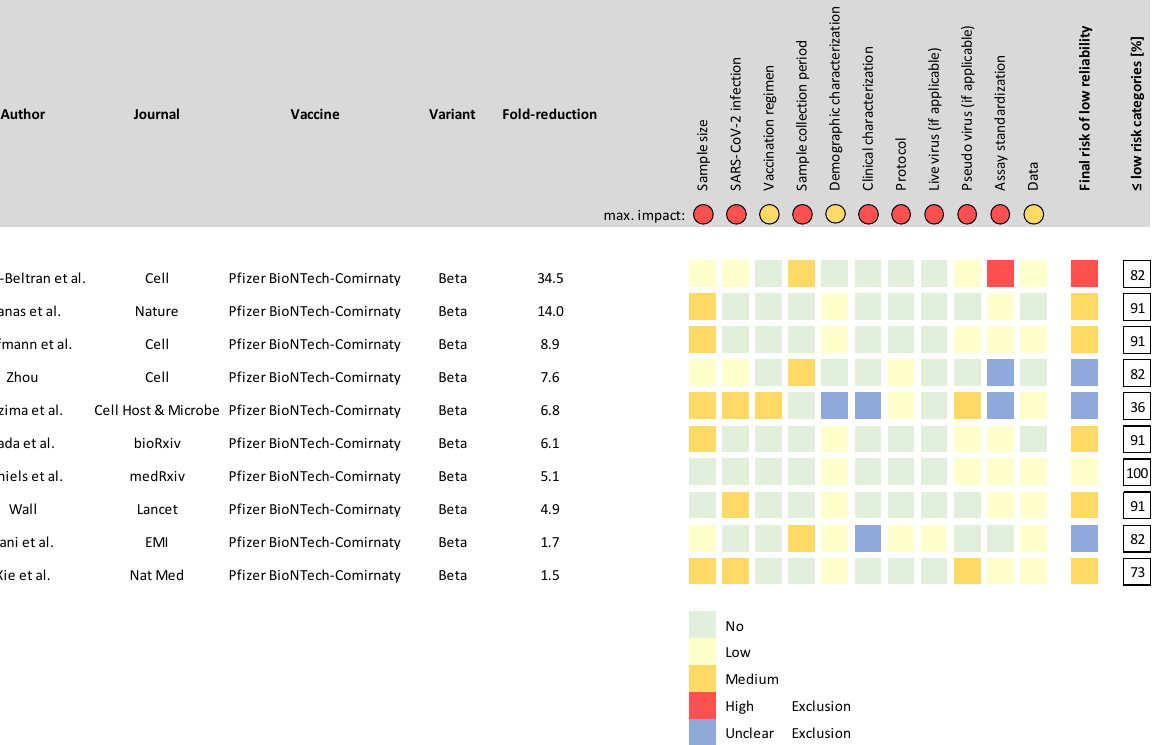
Figure 1. Reliability assessment of ten selected studies reporting post-vaccination neutralization antibody titers against SARS-CoV-2 as determined using the RAT. Ten studies reporting fold-changes in neutralization capacity against the Beta variant and reflecting the full spectrum of the reported fold changes were assessed with the RAT. The aspect-specific impact on reliability is indicated in color-coded boxes on the right of the study, and the overall risk of low reliability is indicated in the same way as “Risk of low reliability”. In the last column, the cumulative percentage of aspects that returned only “no” or “low” risk of low reliability for each study is reported to further stratify the overall reliability.